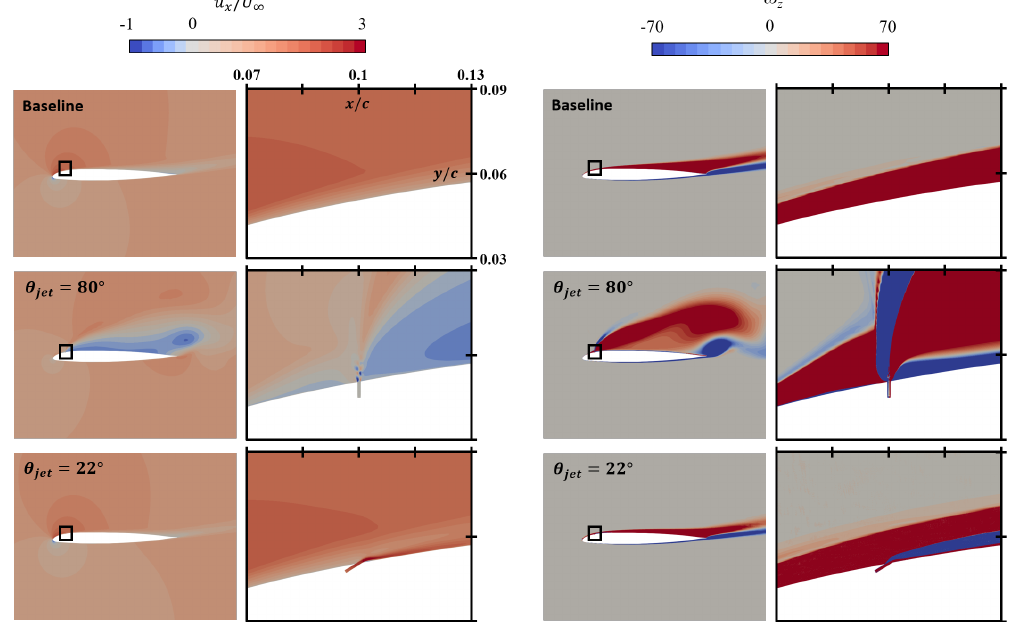
Figure 8. Time-averaged flow field around the OA209 airfoil with and without steady-blowing jets. Ma = 0.3, Re = 1.15 M, c µ = 0.06 and α = 14 ◦